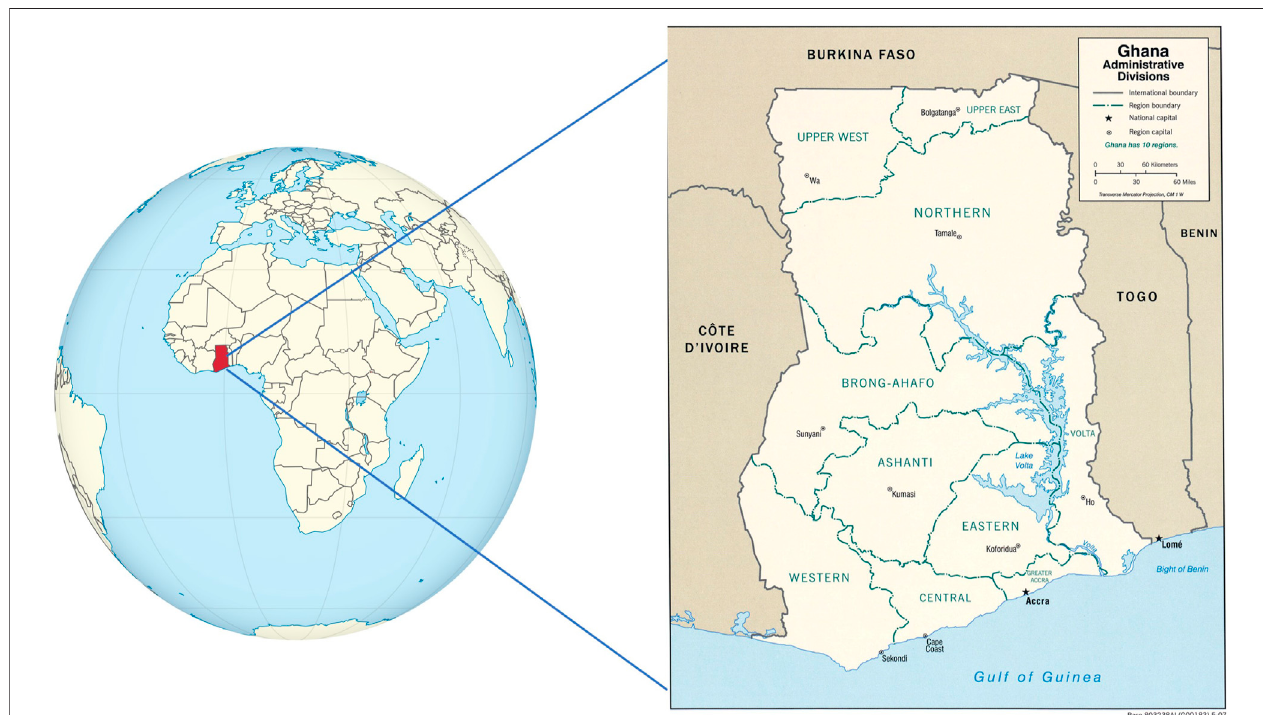
FIGURE 1 | Ghana, location within the larger West African region, major cities, and regional